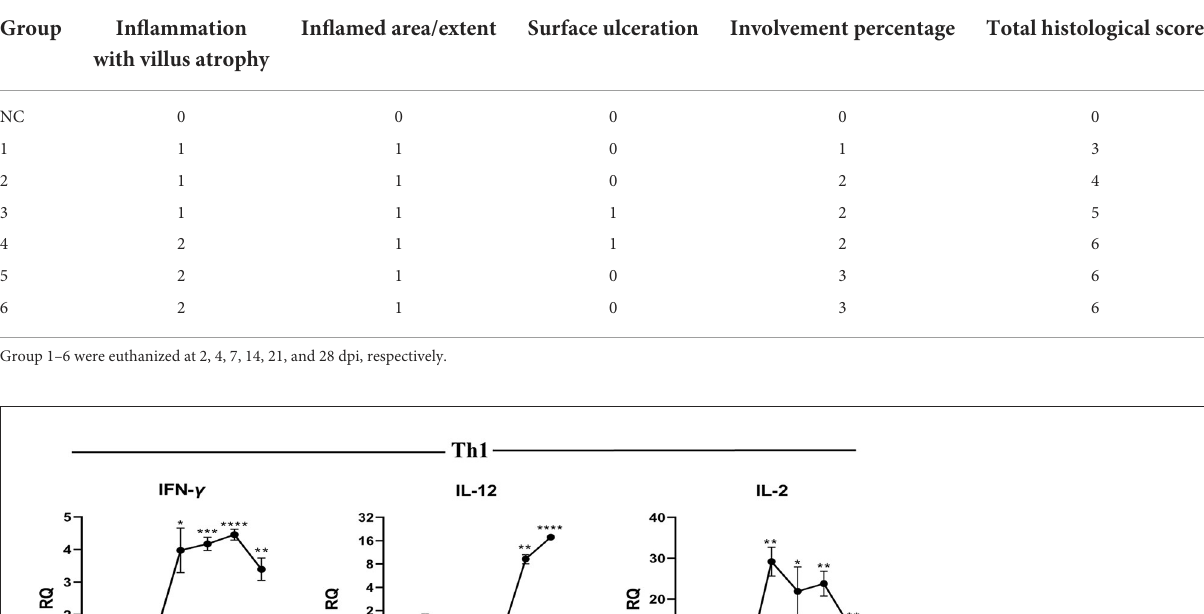
high until 7 dpi ( p = 0.0418) followed by a non-significant change between 14 and 28 dpi compared to non-infected